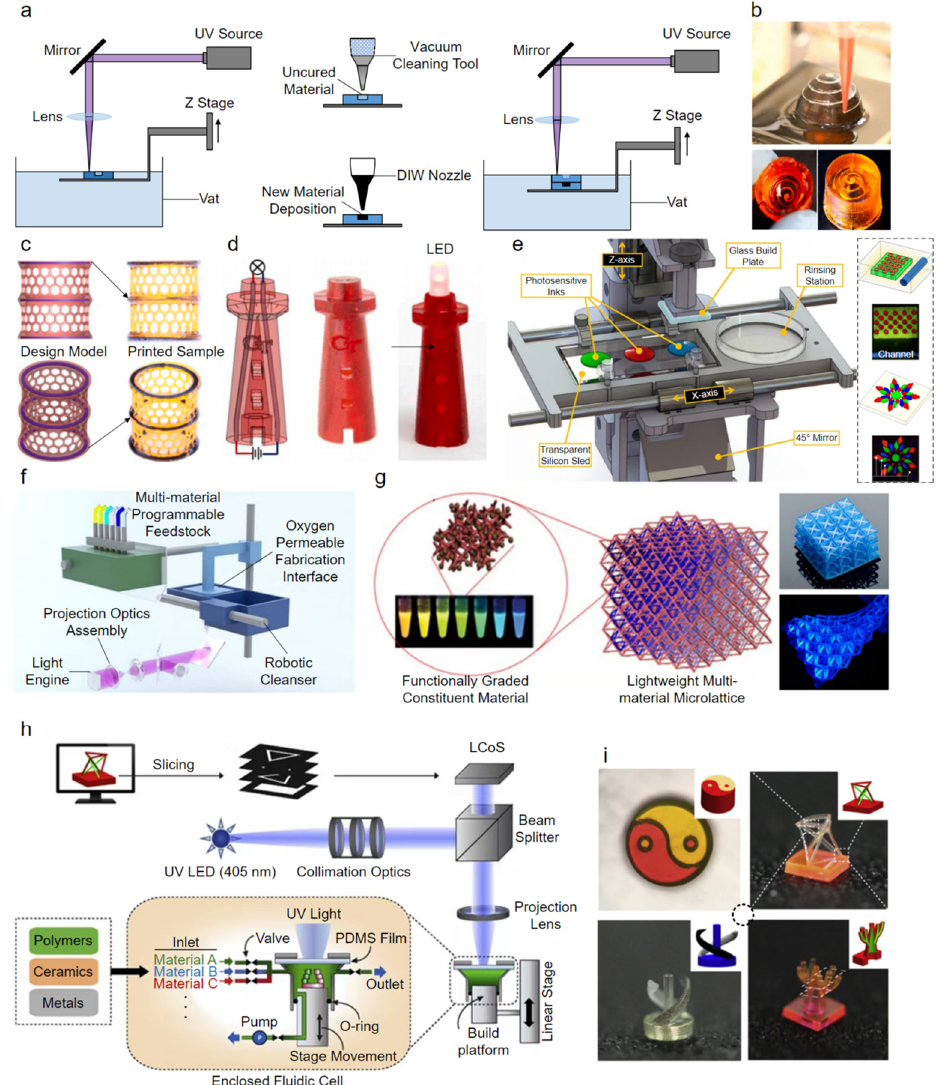
Figure 8. Multi-material 3D printing with VP-based technologies. ( a ) Schematic illustration of the multi-material 3D printing system integrating SLA and DIW. ( b ) Photographs of the printed electronic structure with an embedded 3D helix, ( c ) photographs of the printed cylindrical lattice with three rings embedded, and ( d ) photographs of the printed light tower [172]. ( e ) Schematic illustration of the multi-material stereolithography without vats [179]. ( f ) Schematic illustration of the multi-material stereolithography using an in situ microfuidic system, and ( g ) photographs of the printed 3D microlattice with dissimilar constituent materials [181]. ( h ) Schematic illustration of the multi-material PµSL system using dynamic fluidic control to rapidly fill and exchange multiple photopolymer materials, and ( i ) photographs of the printed micro 3D structures [183].